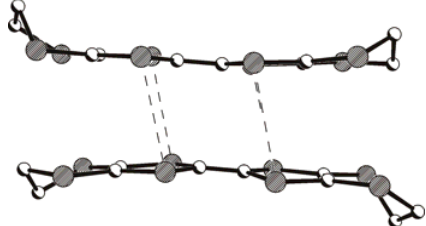
B H )(1',2'-C 2 9 9.91